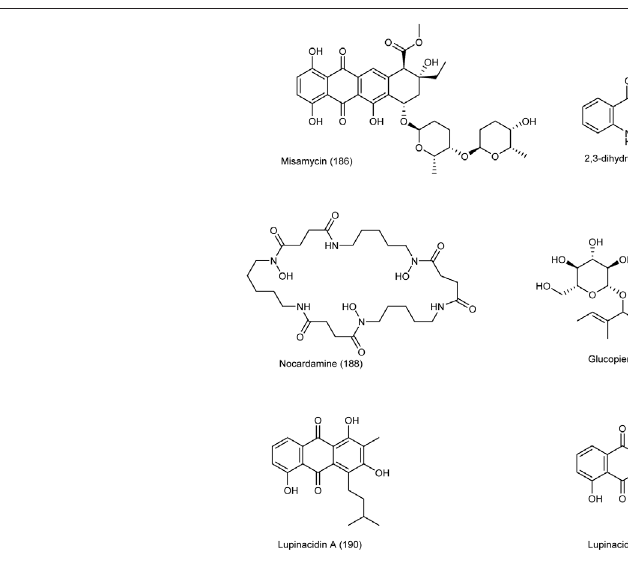
Frontiers in Pharmacology |